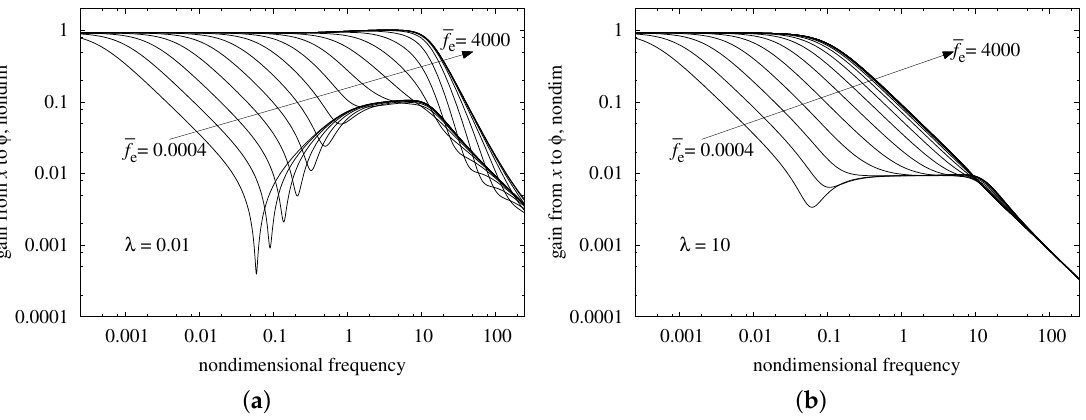
Figure 3. Frequency response under amplifier variation with and without eddy current effects. ( a ) Gain from rotor displacement to flux without eddy current effects ( λ = 0.01); ( b ) gain from rotor displacement to flux with strong eddy current effects ( λ = 10).